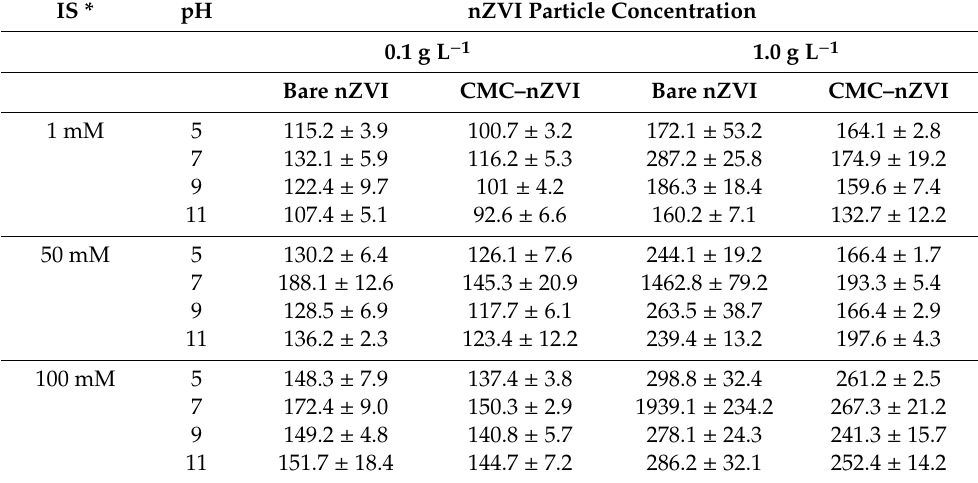
Table 1. E ff ect of nZVI particle concentration, CMC polymer stabilizer, ionic strength (IS) and pH on the hydrodynamic size of